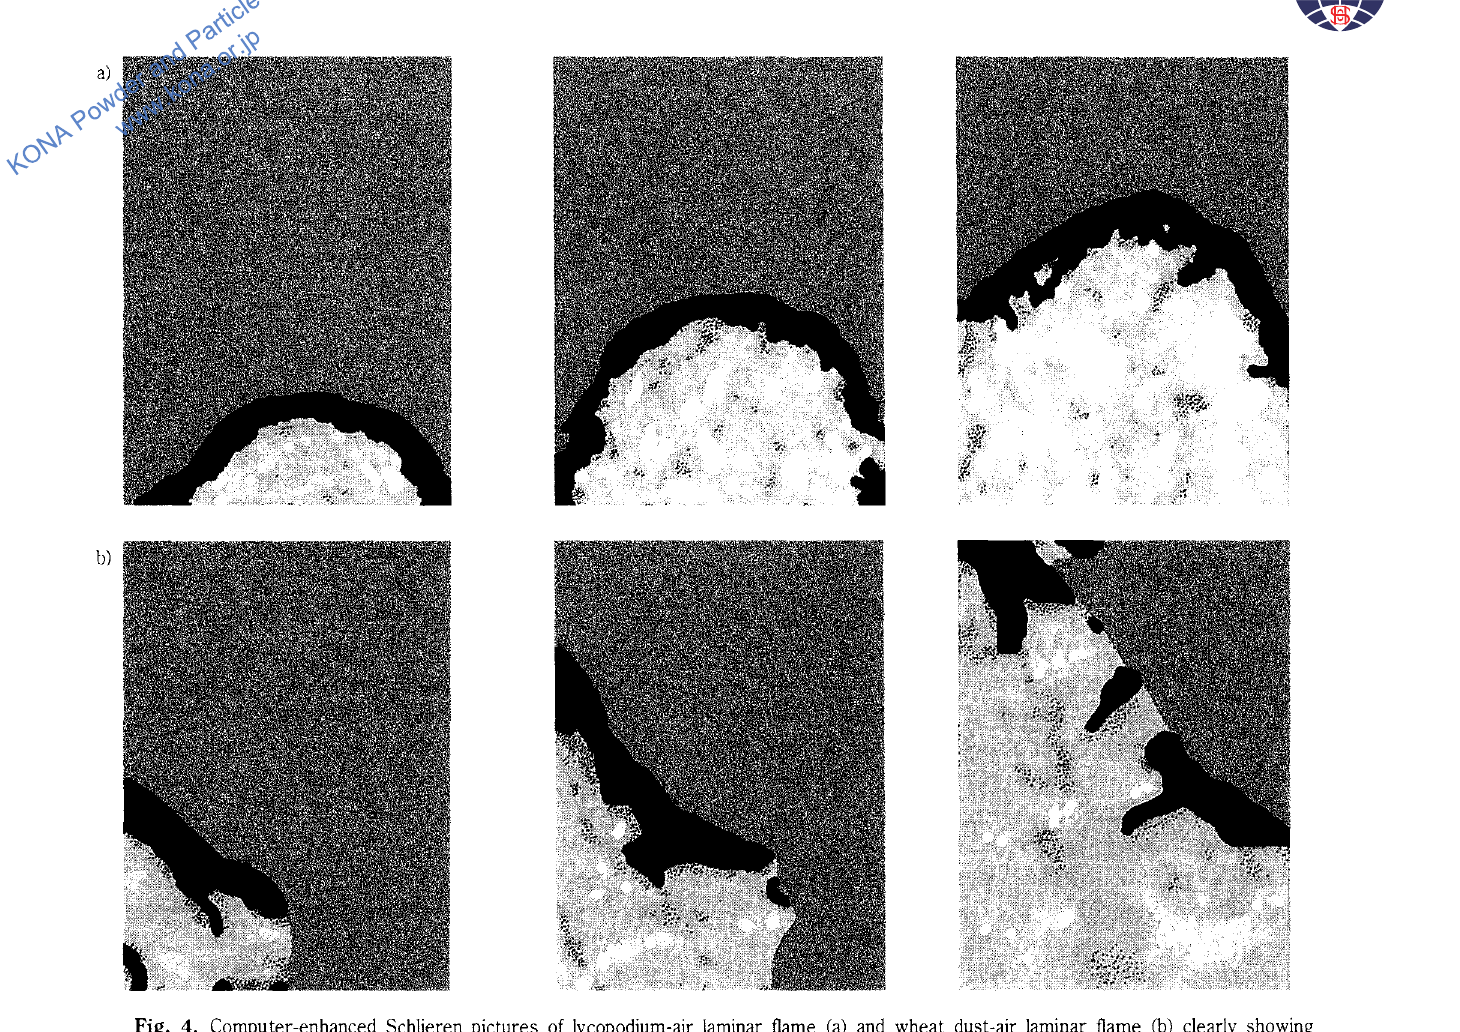
Fig. 4. Computer-enhanced Schlieren pictures of lycopodium-air laminar flame (a) and wheat dust-air laminar flame (b) clearly showing preheated zone area and combustion regions